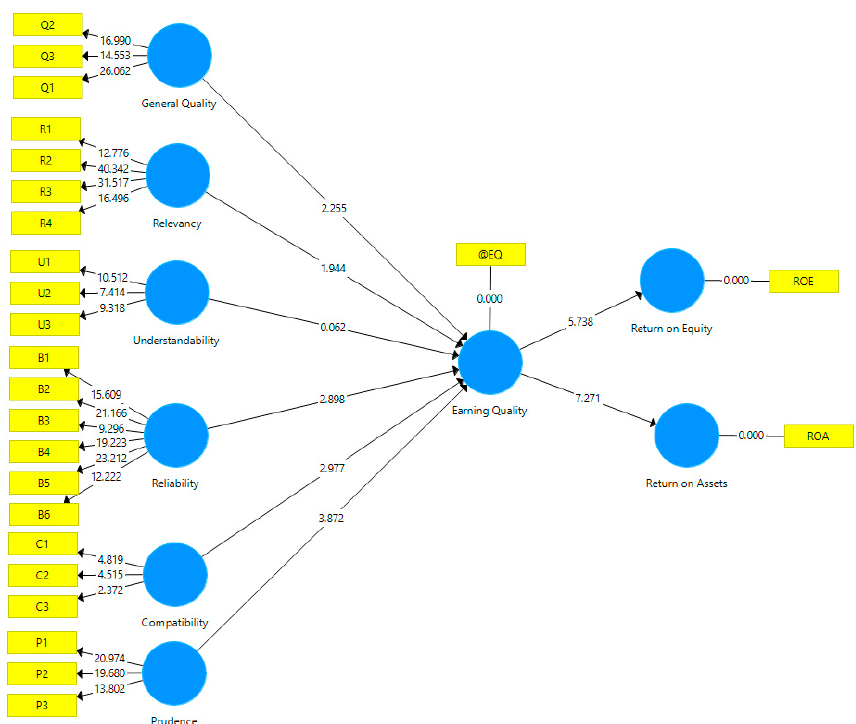
Figure 2. Research Model with Hypotheses Testing. Source: Developed by the author based on software results.